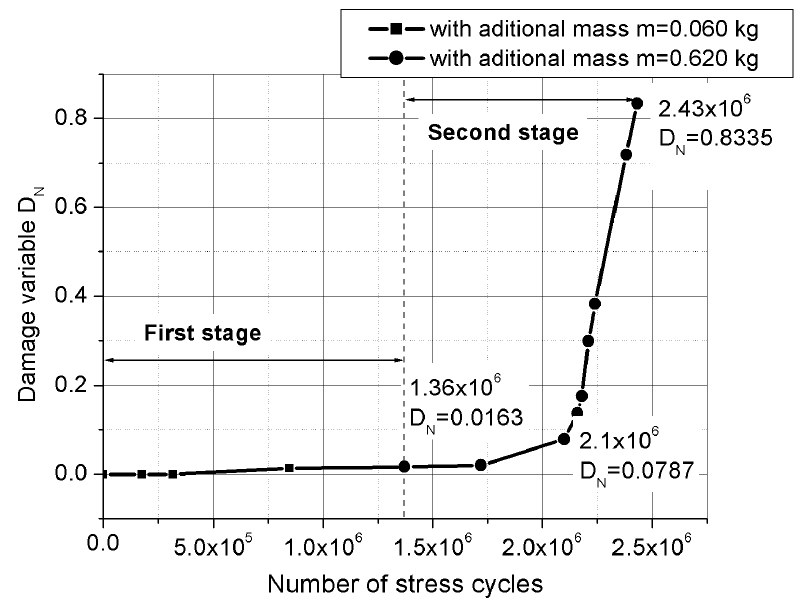
Figure 19. Evolution of the macroscopic damage variable with number of cumulative cycles. Figure 20 captures the breaking moment of the tested device.